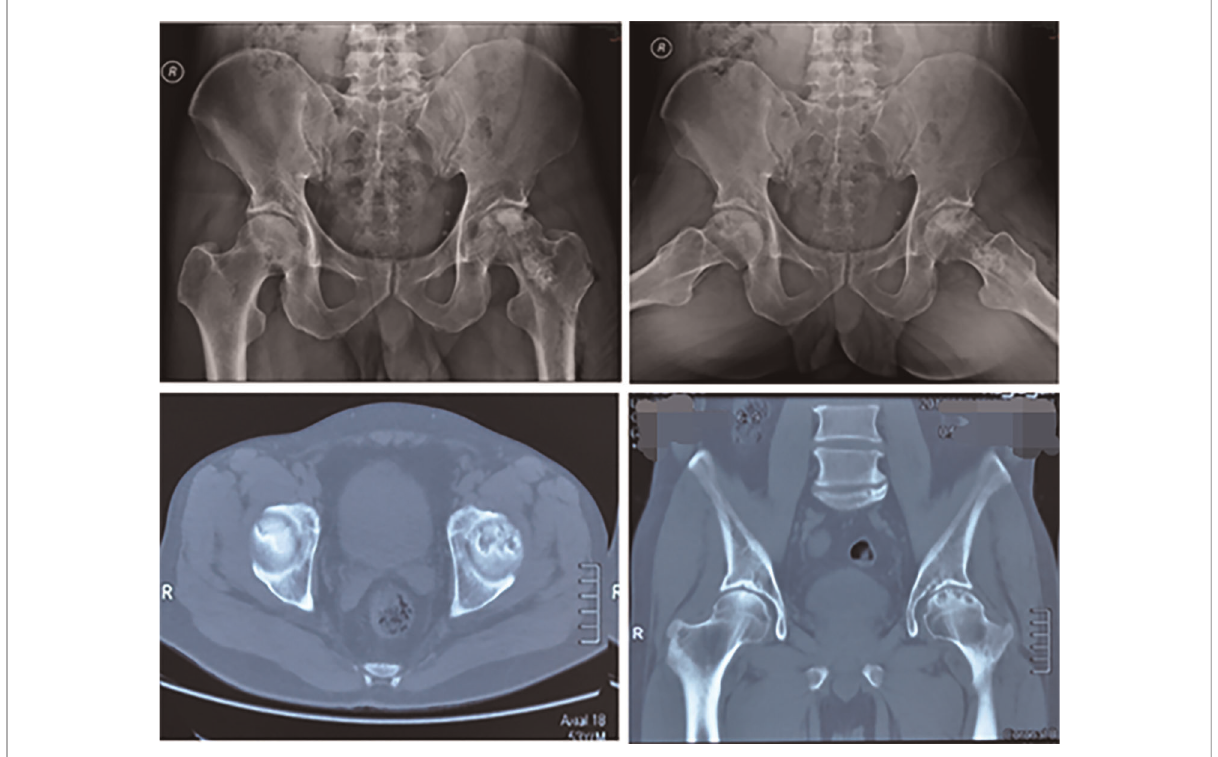
FIGURE 1 X-ray and CT image results of bilateral femoral heads obtained at the time of the fi rst